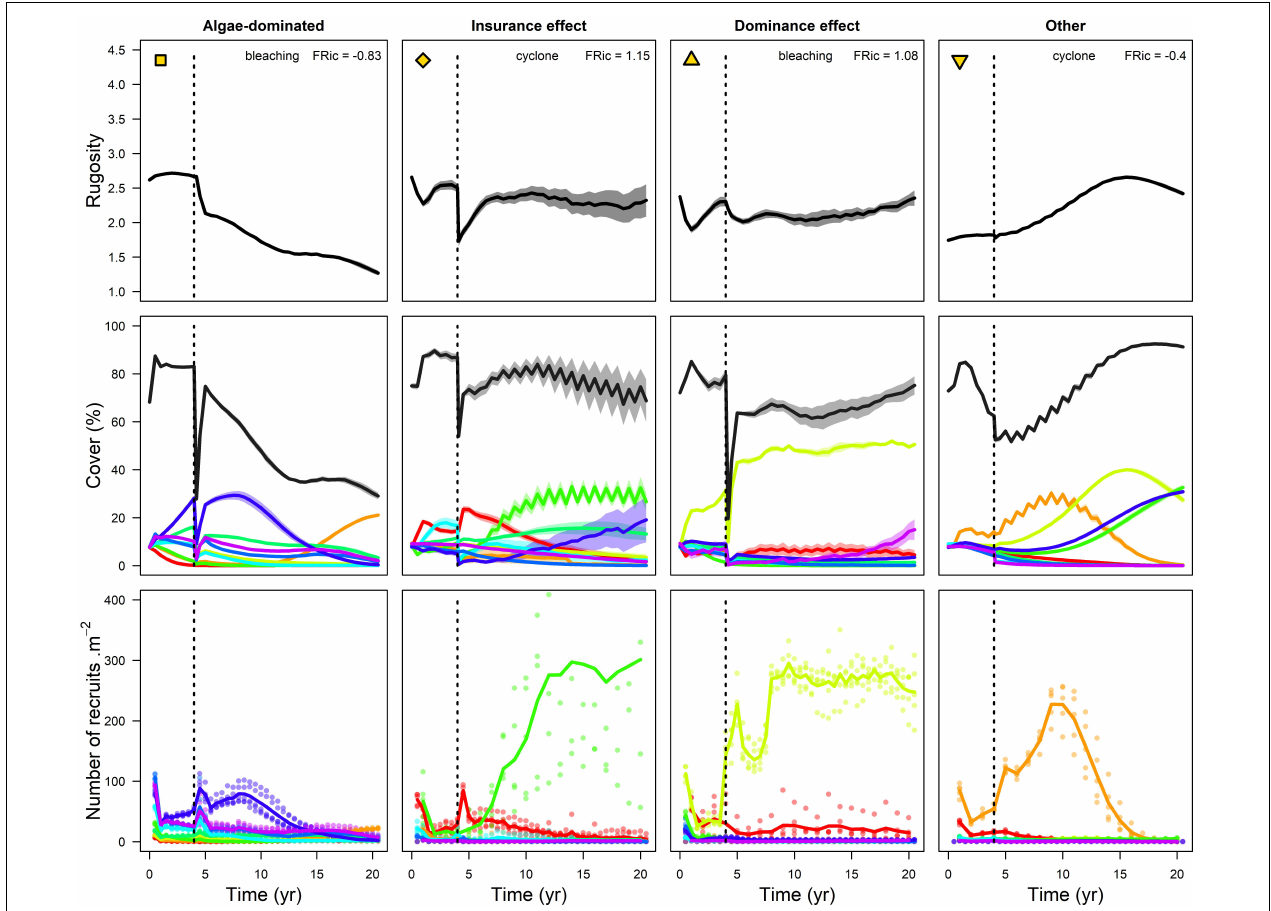
FIGURE 7 | Examples of community dynamics for each category shown in Figure 6 . Top row represents the rugosity created by the colonies; the (middle row) displays individual species’ cover in color and total coral cover in black; the (bottom row) shows the density of recruits for each species (solid lines and shaded areas represent mean ± standard error over five replicates; each dote is the number of recruits. m − 2 at a given time for a given replicate). Symbols on the top left corner of the plots in the first row are used to indicate where these communities are in Figure 6 and in the variable space in Figure 5 and Supplementary Figures 12, 14, 17, 20